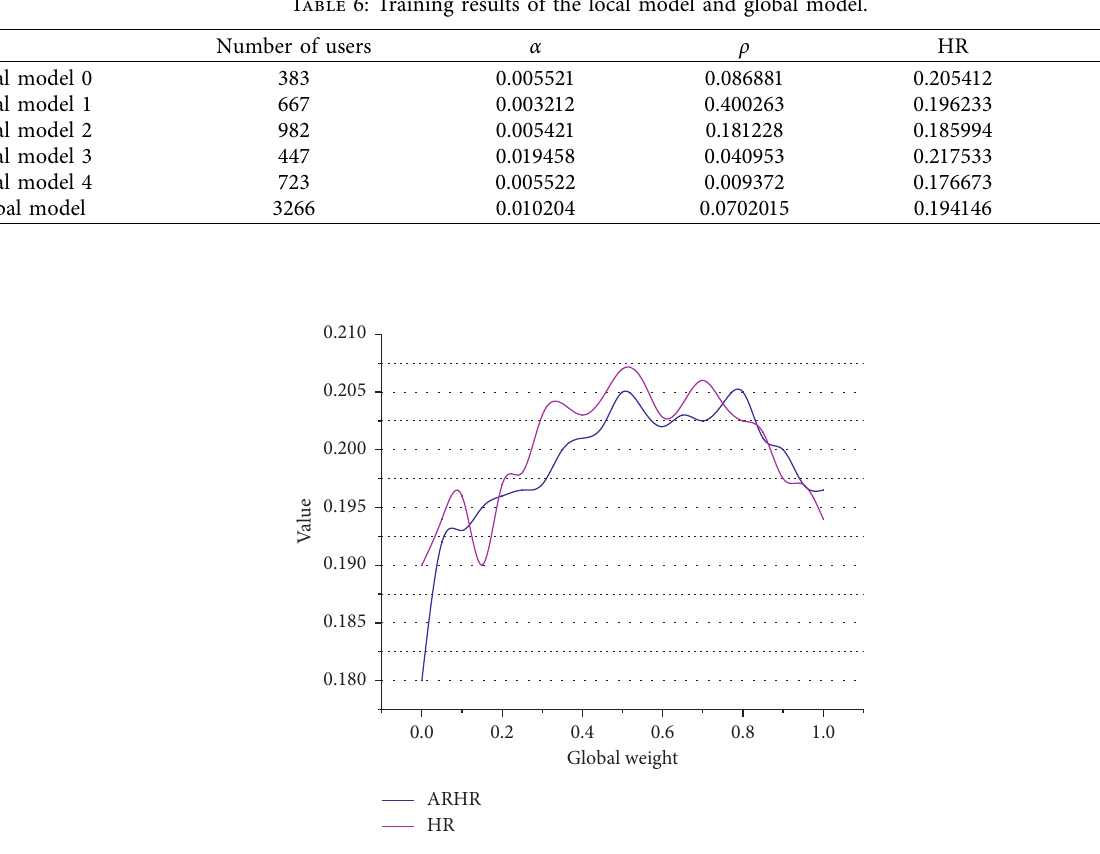
Figure 8: Fusion results using different global